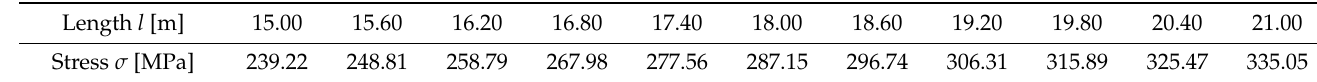
Table 7. Extreme reduced stresses in the external weld in the truss